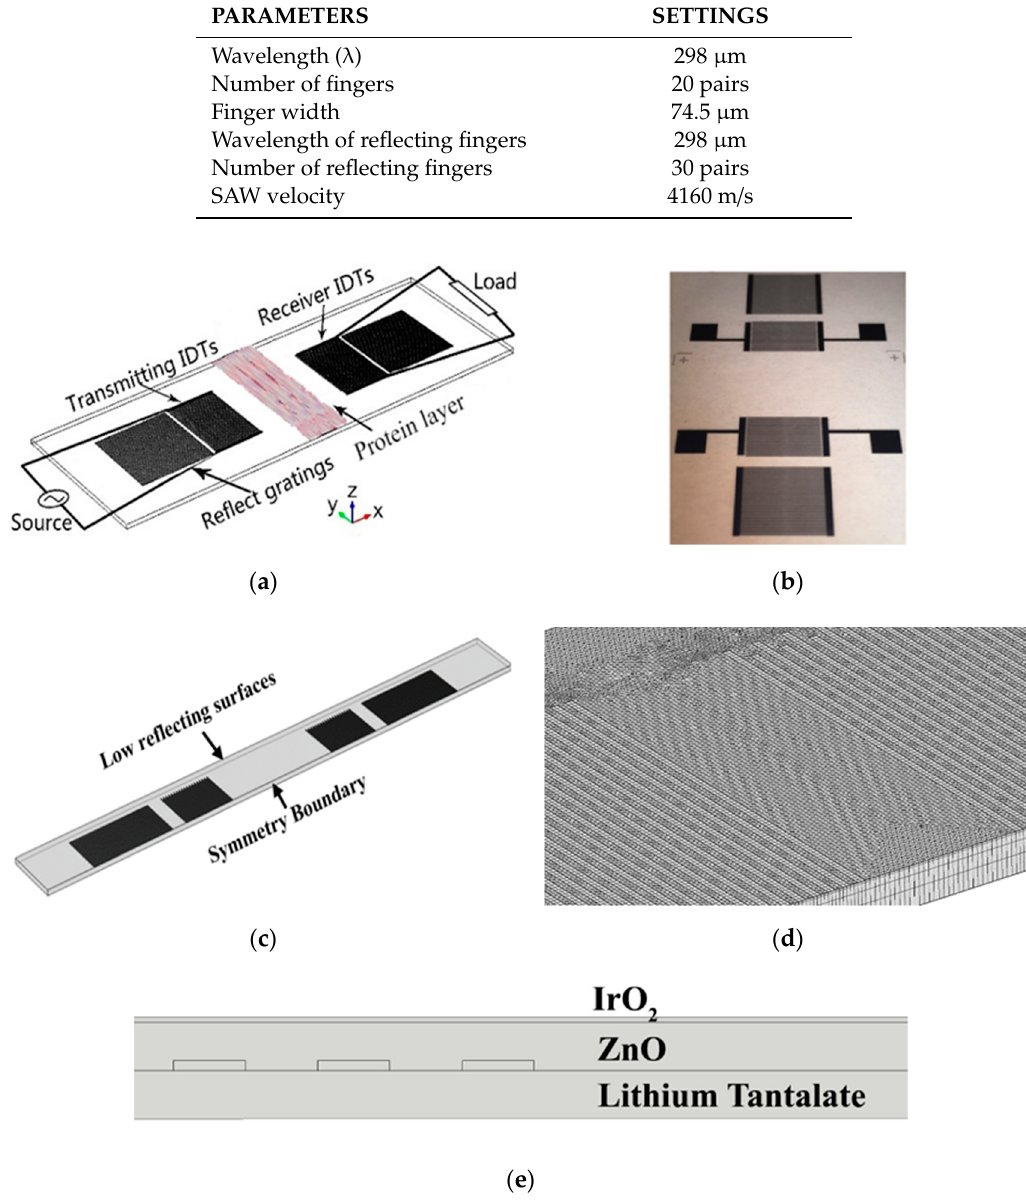
Figure 1. ( a ) Schematic diagram showing the design and structure of the real SAW device. ( b ) Fabricated device with only the finger layer. ( c ) The 3D model of the device used in COMSOL. ( d ) The completed mesh of the model. ( e ) Conceptual view of the double guide layer of the SAW device. Table 1. Device IDT parameters used in both device fabrication and modeling.